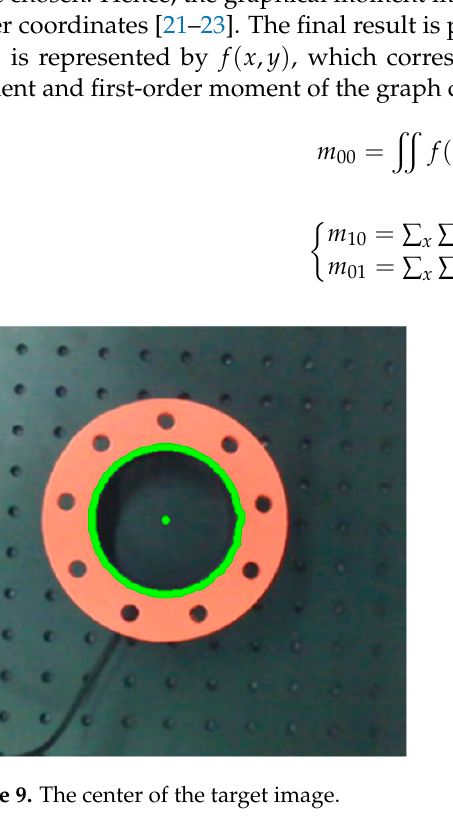
Figure 9. The center of the target image.